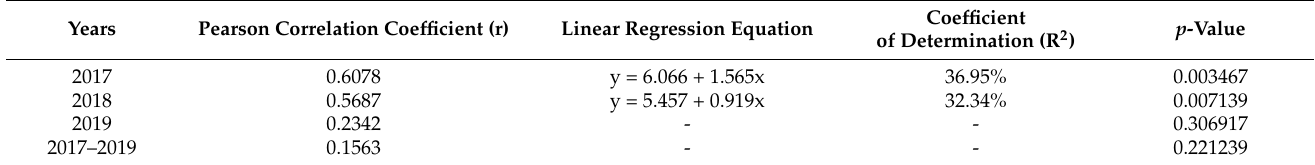
Table 13. Linear relationships between grain yield and magnesium content in maize leaf blades at BBCH 65.